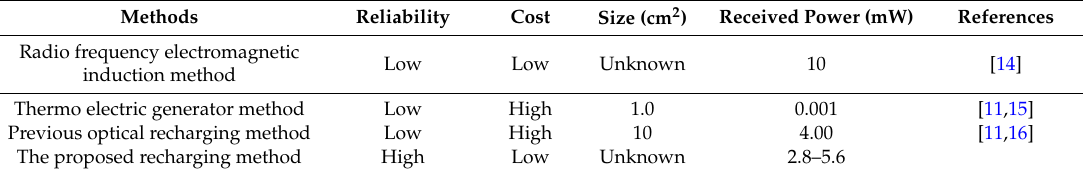
Table 1. Comparison between the recharging method using sunlight and other methods.